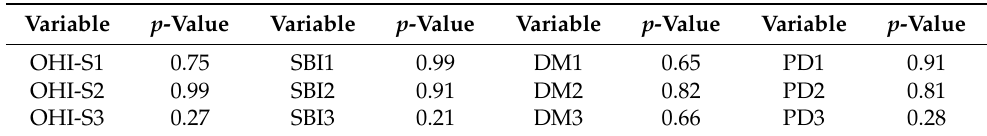
Table 5. Chi-Square test p -values for test differences between groups, for all variables, at all “three levels of investigation”.